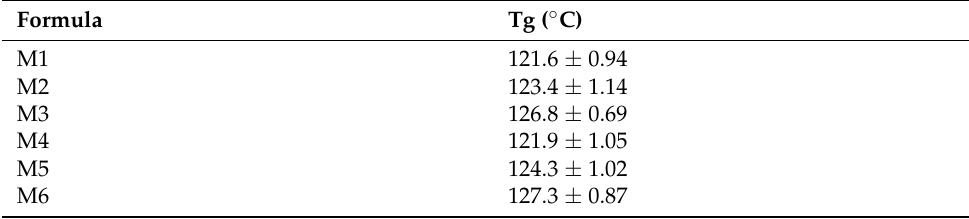
Table 2. Thermal characterization of the pellets